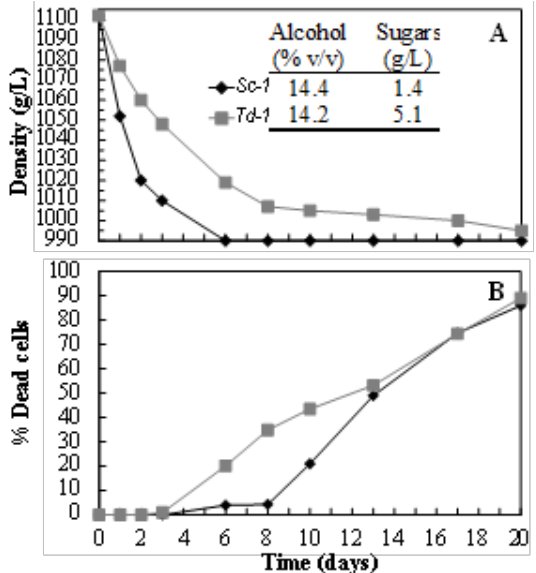
Figure 4. Must fermentation kinetics ( A ) and proportion of dead cells ( B ) of Garnacha grape fermentation inoculated with S. cerevisiae ( Sc ) and T. delbrueckii ( Td ). The concentrations of ethanol and residual sugars in the wines are given.